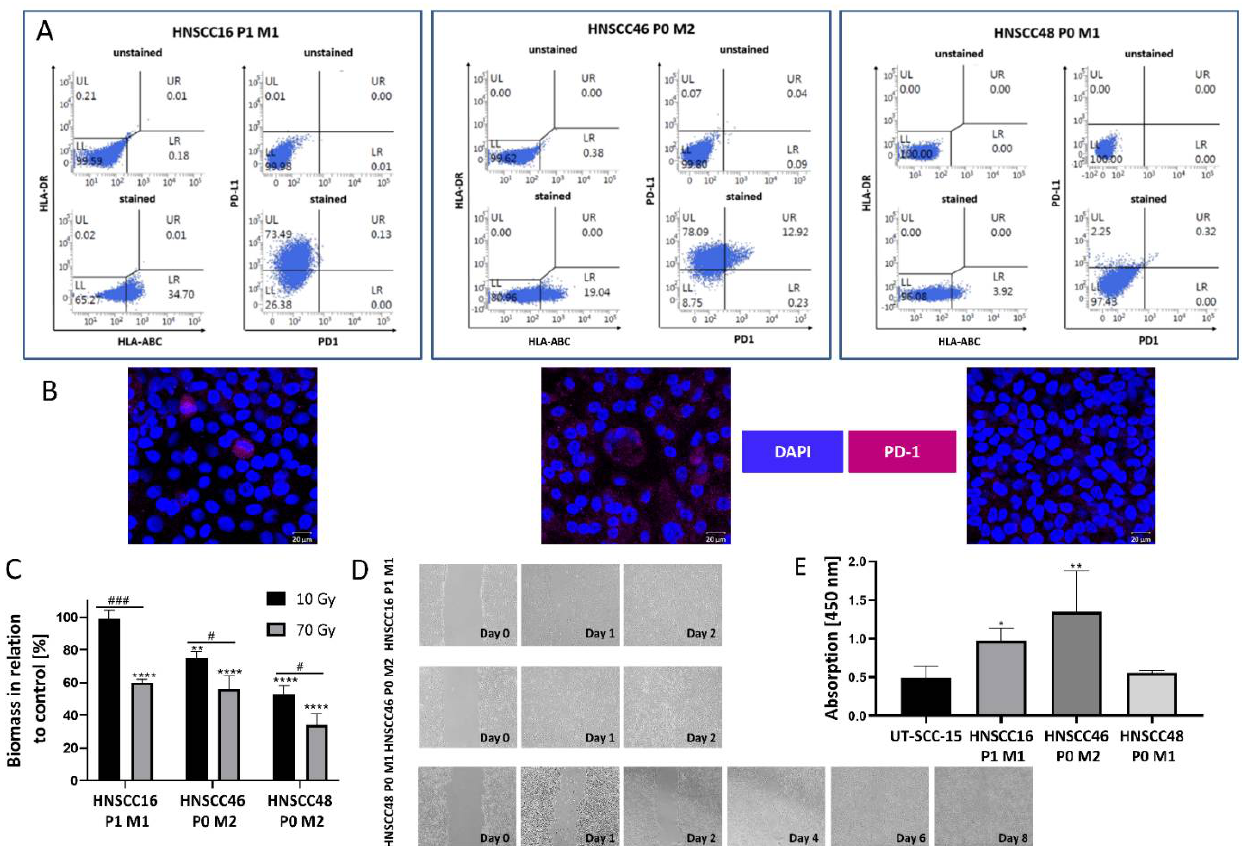
Figure 3. Basal characterization including phenotyping, radiation response, migration, and invasion of untreated HNSCC cell lines ( A ) FACS-based phenotyping for HLA-ABC, PD-1, and PD-L1 (left) and ( B ) immunofluorescence staining of PD-1 (right) to confirm PD-1 on the surface of HNSCC46 P0 M2. A read out was conducted with the ZEISS Elyra 7 Confocal Laser Microscope (Zeiss). Original magnification 400×. ( C ) Radiation response was examined after 5 fractions of 2 Gy and 14 Gy on 5 consecutive days, resulting in a total radiation dose of 10 Gy (black columns) and 70 Gy (grey columns). A readout was conducted by crystal violet staining and biomass quantified in relation to non-irradiated controls. Unpaired t-test (n = 3 independent experiments) # p < 0.05; ### p < 0.001 vs. 70 Gy; one-way ANOVA, (n = 3 independent experiments) ** p < 0.01; **** p < 0.0001 vs. control (100%). ( D ) Migratory potential was investigated via scratch-assay. The scratch was monitored daily by light microscopy (original magnification 100×) until the wound was closed. ( E ) Matrigel-invasion assay. Invasive behavior was studied compared to UT-SCC-15, a cell line derived from a nodal HNSCC recurrence. A readout was conducted with WST-1 assay. The absorbance at 450 nm is shown. One-way ANOVA (n ≥ 3 independent experiments) * p < 0.05; ** p < 0.01 vs. invasion of UT- SCC-15.